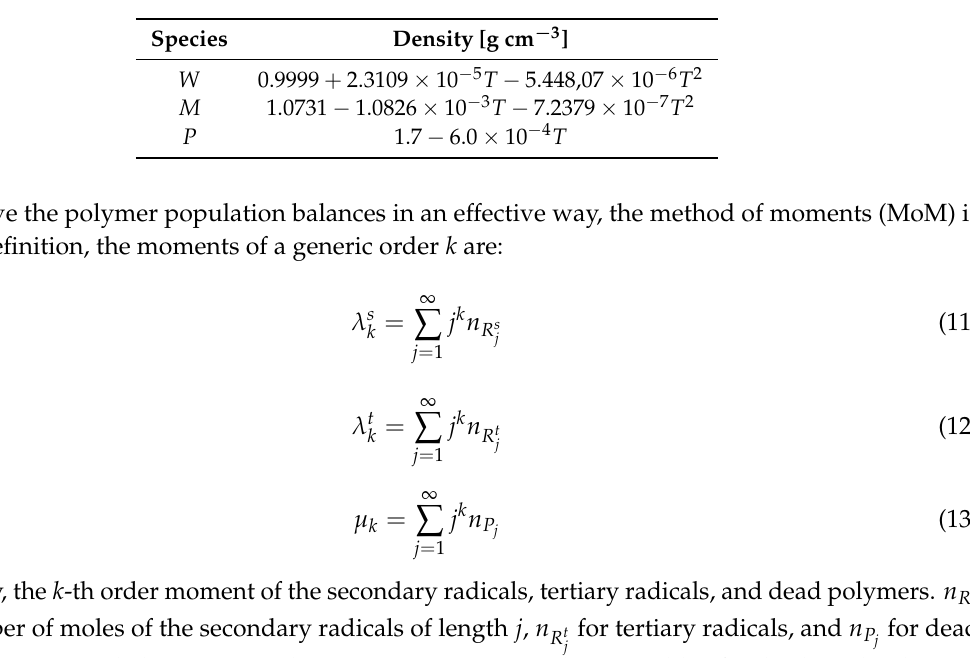
Table 3. Pure species density as a function of temperature [14,20]. Temperature in [ ◦